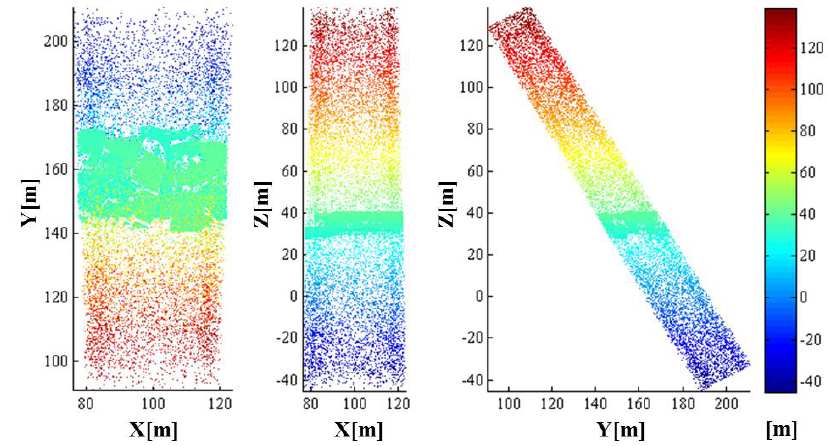
Figure 18. The simulated point cloud with colors encoded by height (front and side views).